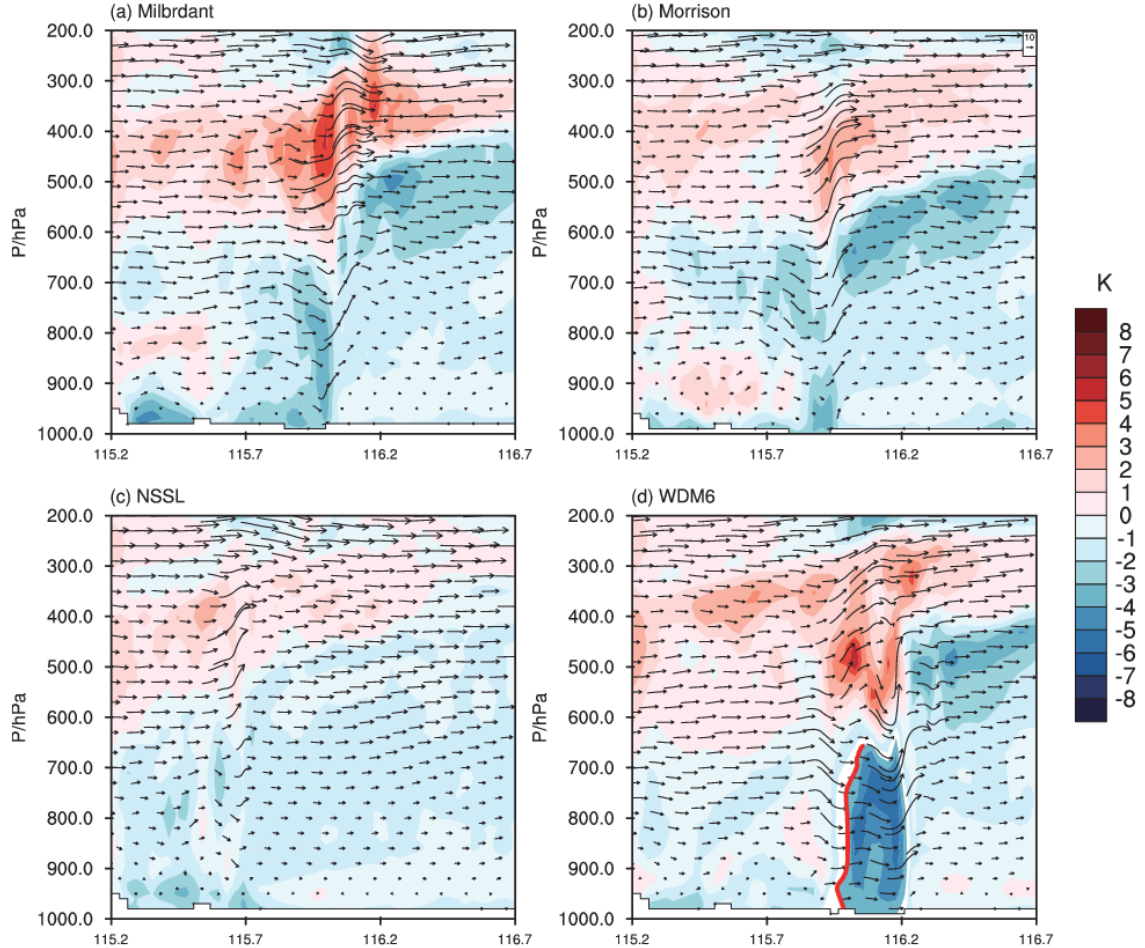
Figure 14. The vertical cross-section of zonally averaged (10 isometric profiles over 28° N – 29° N) wind vectors [vector, (u, 10 w), units: m·s −1 ] and perturbation potential temperature (shaded, unit: K) at 2230 UTC 15 April 2016 with four different double-moment MP schemes. The red thick line in Figure 14d is the cold pool boundary. The square box in the upper − right corner in ( b ) shows 10 m·s −1 wind.